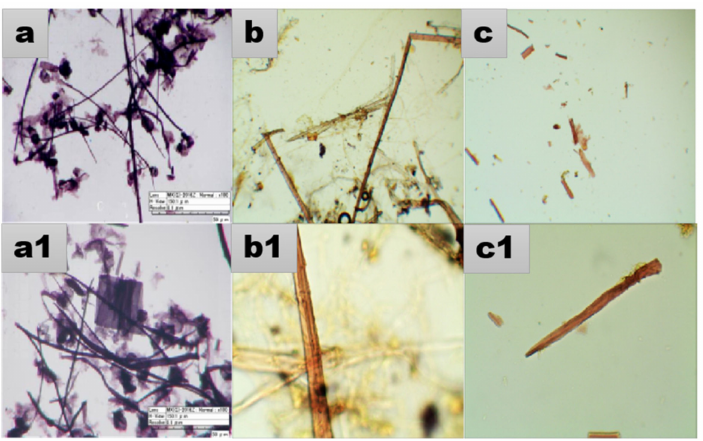
Figure 5. The morphology of the paper fiber ( a , a1 ) is the caisson painting paper; ( b , b1 ) and ( c , c1 ), are the light-colored bottom painting with a rough surface and the dark-colored bottom painting with a smooth surface and brittle texture,